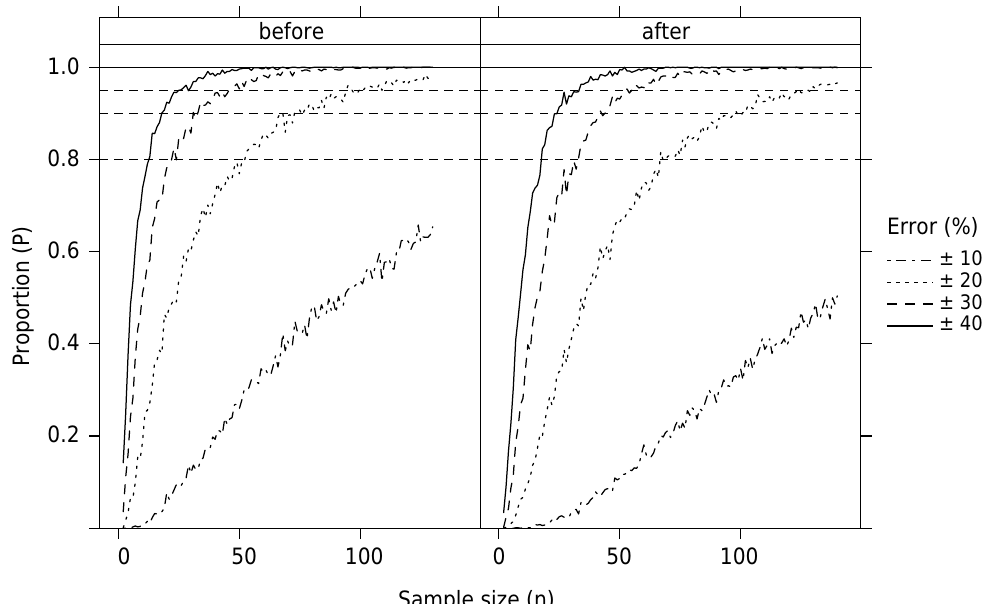
Figure 6. Proportion of bootstrap vertical profiles of sample mean of cone index (CI) values that fall within the ± 10, 20, 30, and 40 % of error around the vertical profile of mean CI values, before and after